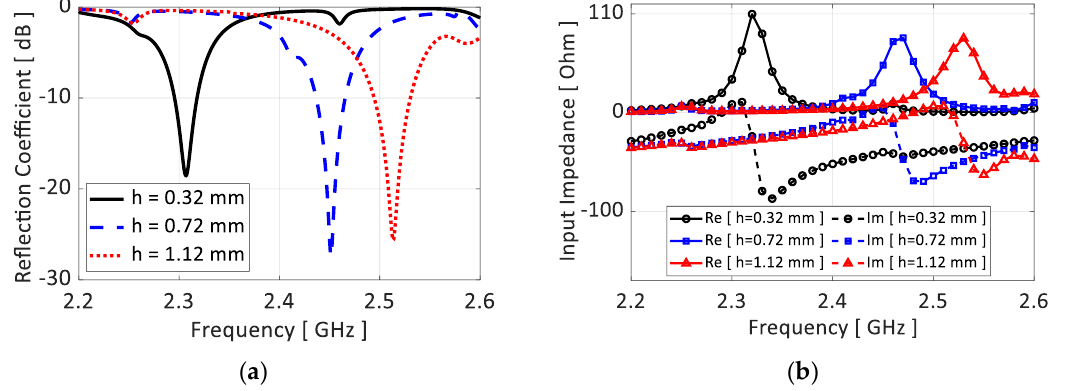
Figure 3. Parameter study results on h: ( a ) Reflection coefficient. ( b ) Input impedance. Table 1. Parameter study results on h.